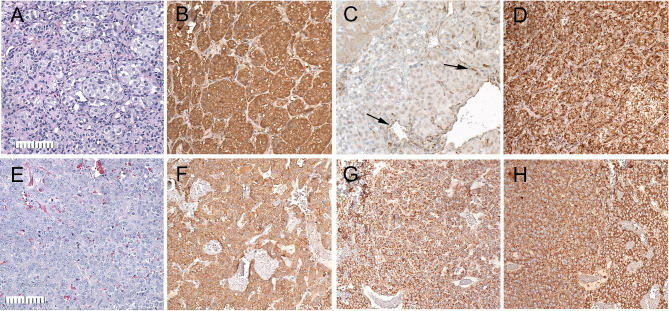
Histology and immunohistochemistry of pheochromocytoma xenografts RS0 (A, B, C and D) and RS1/2 (E, F, G and H). (A and E) Hematoxylin and eosin stain (B and F). Tyrosine hydroxylase RS0 shows classic ‘Zellballen’ pattern characteristic of pheochromocytomas and extra-adrenal paragangliomas, while RS1/2 shows diffuse growth. (C and G) SDHB. RS0 shows loss of granular cytoplasmic staining for Sdhb in tumor cells and retained dark granular staining in endothelial cells (arrows). In contrast RS1/2 shows positive staining in both tumor and endothelial cells. (D and H) SDHA. Both RS0 and RS1/2 show positive staining in tumor cells and endothelilium. Bar = 100 µm.